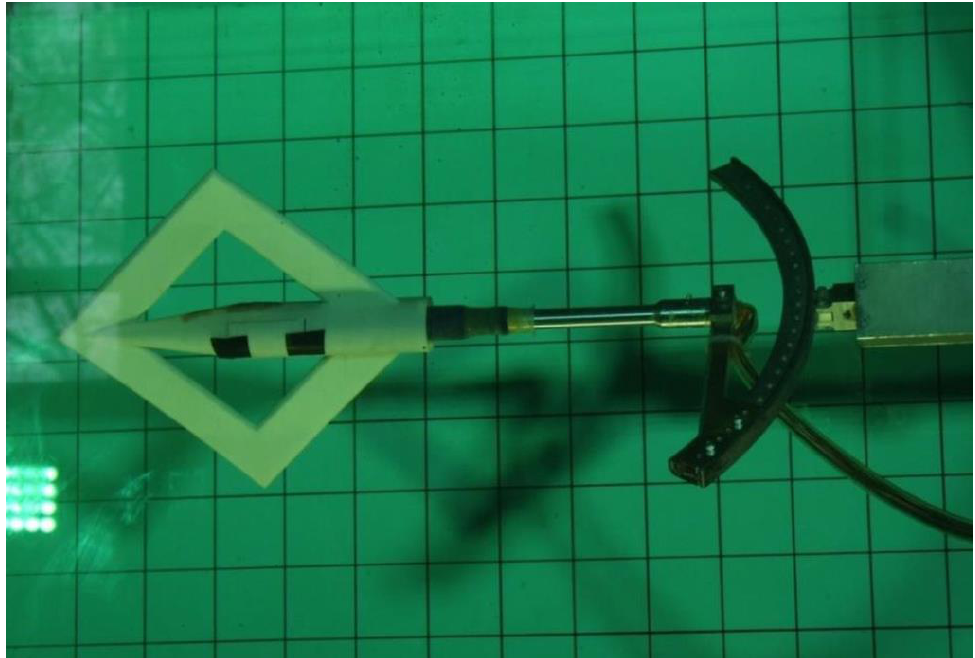
Figure 1. The main dimensions of the FlatFlyer model plane with mean aerodynamic chord marked red (Ca) .